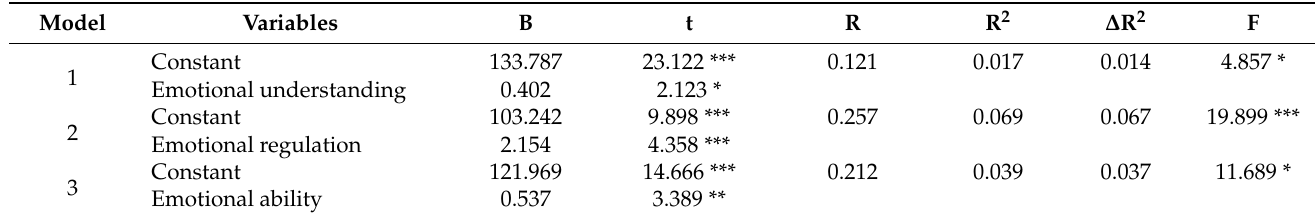
Table 7. Regression analysis of emotional ability and resilience.